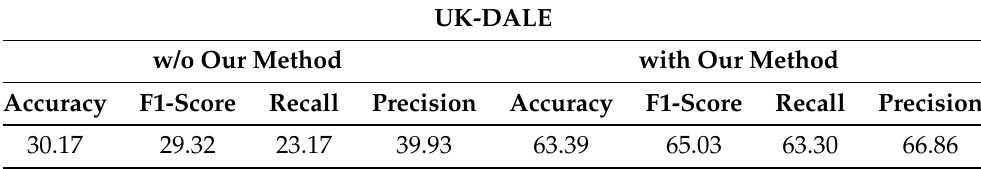
Table 11. The results of combinations of five appliances with Xception (UK-DALE).